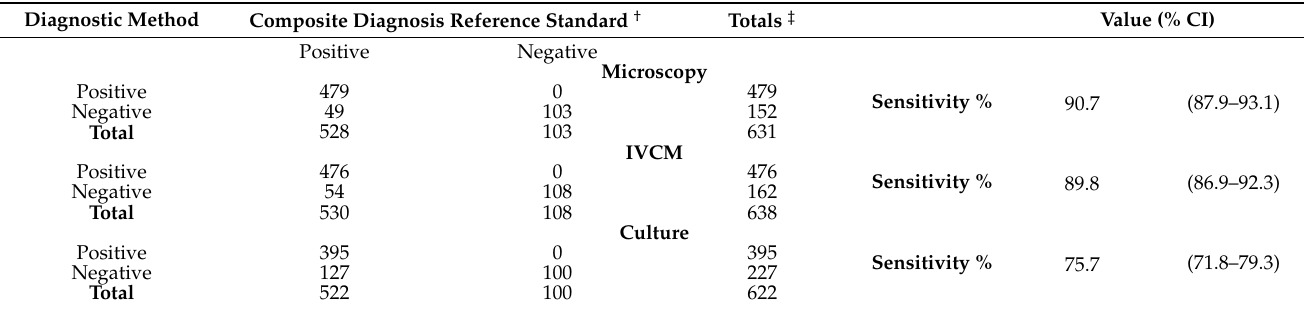
Table 2. Sensitivity values for detecting filamentous fungi ( n = 532) using smear microscopy, in vivo confocal microscopy, and culture compared to a composite diagnosis reference standard (mixed bacterial-fungal infections included). The number of positive and negative test results are shown on the left. The sensitivity values are shown on the